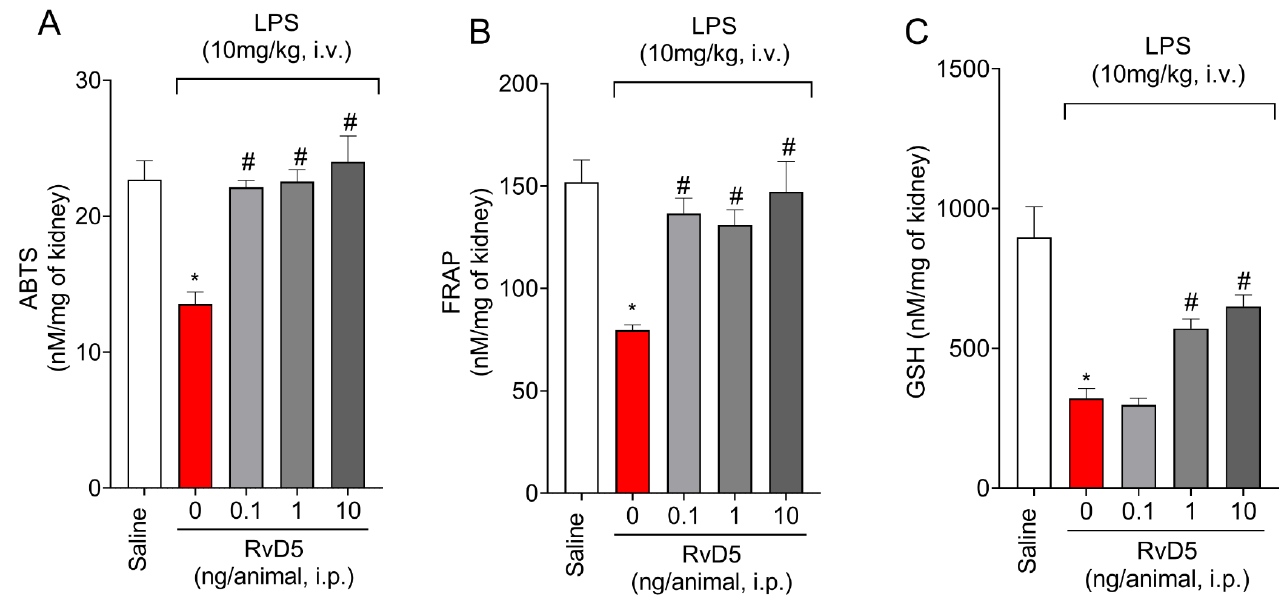
Figure 4. RvD5 reestablishes tissue antioxidant capacity. ABTS ( A ), FRAP ( B ) and GSH ( C ) were quantitated in the kidneys. Results are presented as mean ± SEM of sixanimals per group and are representative of two replicates. (* p < 0.05 vs. saline, # p < 0.05 vs. LPS 10 mg/kg; one-way ANOVA followed by Tukey’s post-test).